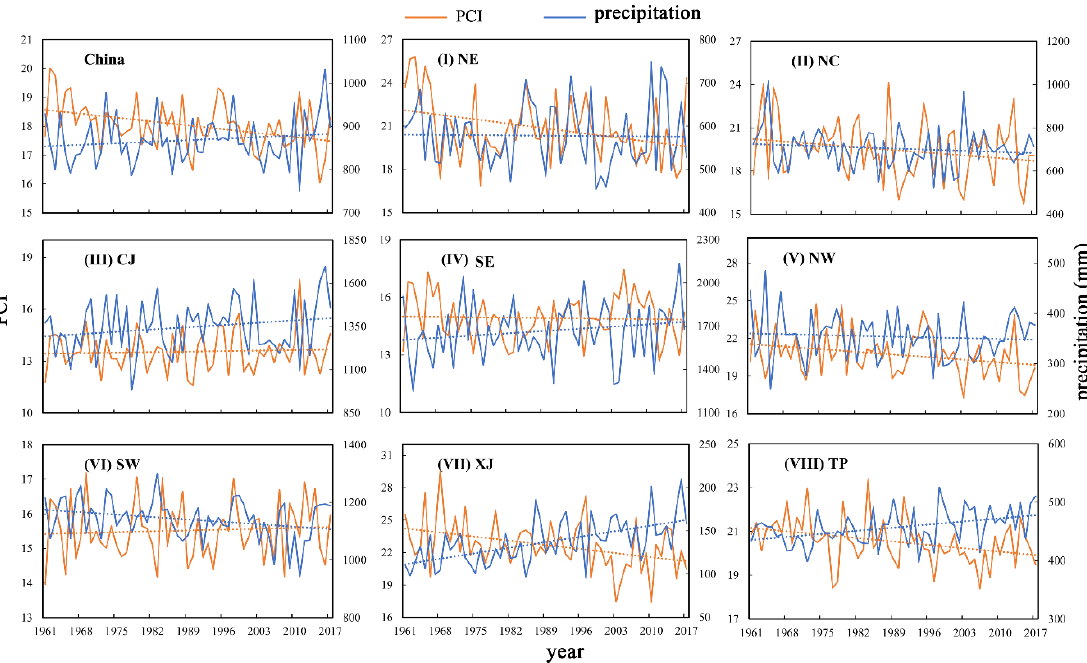
Figure 6. Time series of the annual precipitation (the blue solid line) and PCI (the orange solid line) for the eight subregions in China: The dashed lines show the corresponding linear trend.